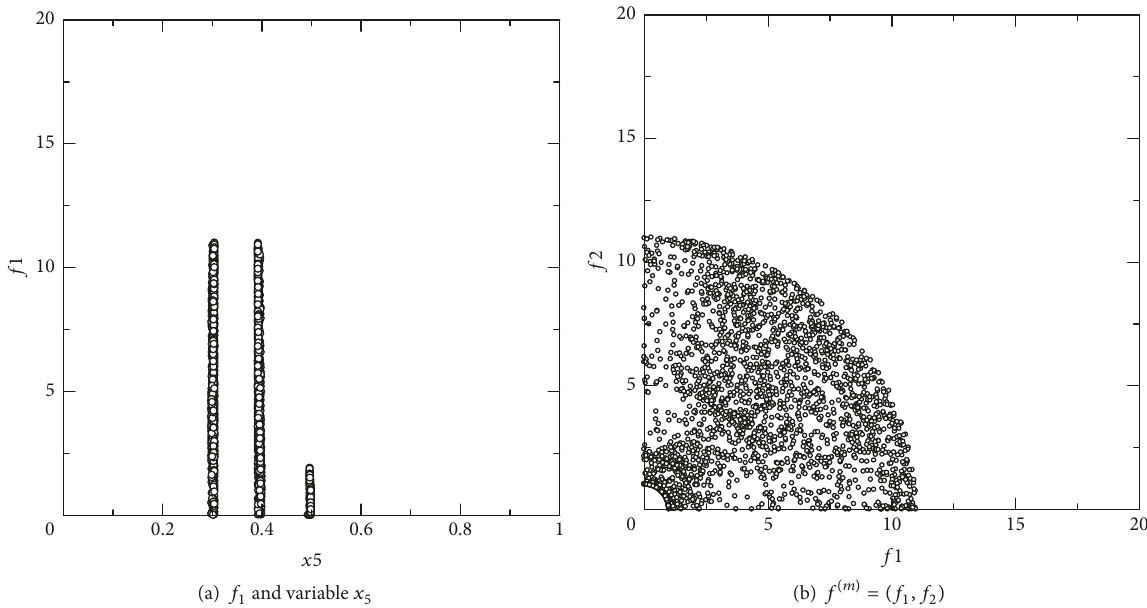
Figure 7: Proposed method searching concurrently on the original space f (𝑚) = (𝑓 1 , 𝑓 2 ) , 𝑚 = 2 , 𝑛 = 5 , and expanded space f (𝑀) , 𝑀 = 4 . Final generation, DTLZ3 problem.